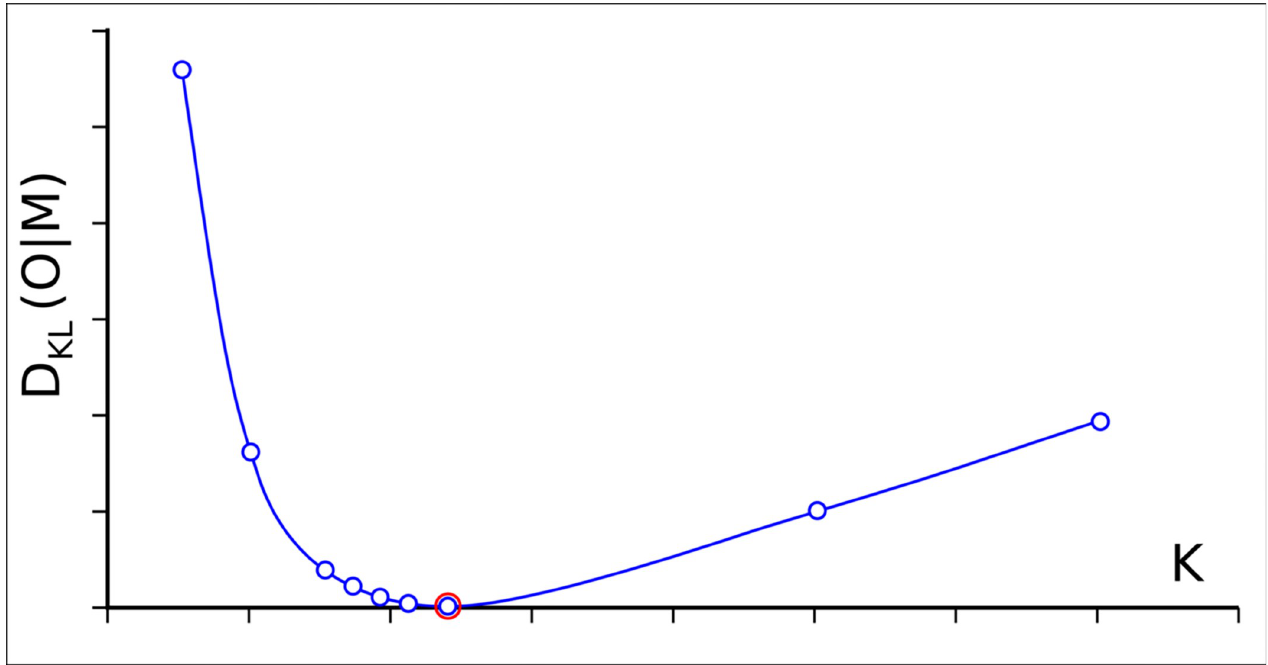
Fig 12. Determining the optimal value of coefficient K . The lowest D KL value is marked (red circle).